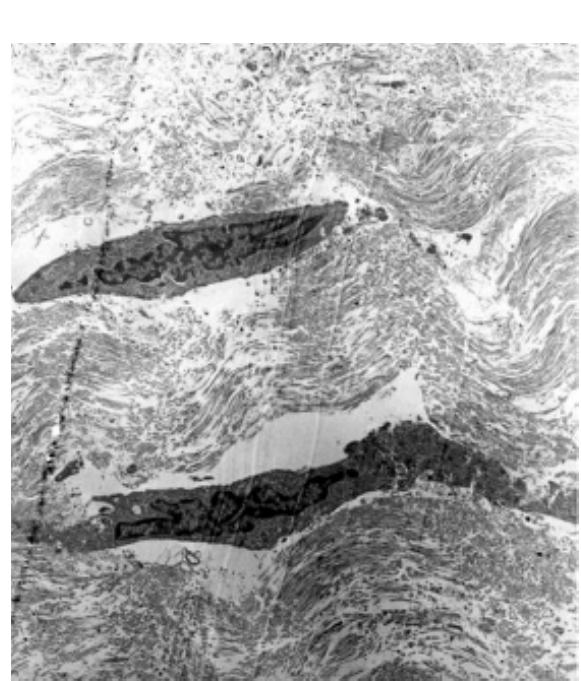
Fig. 5 – Microscopia eletrônica de transmissão da válvula não- aldeídica (L-Hydro). Fibroblastos viáveis incorporados à matriz do colágeno (magnificação 28000x)